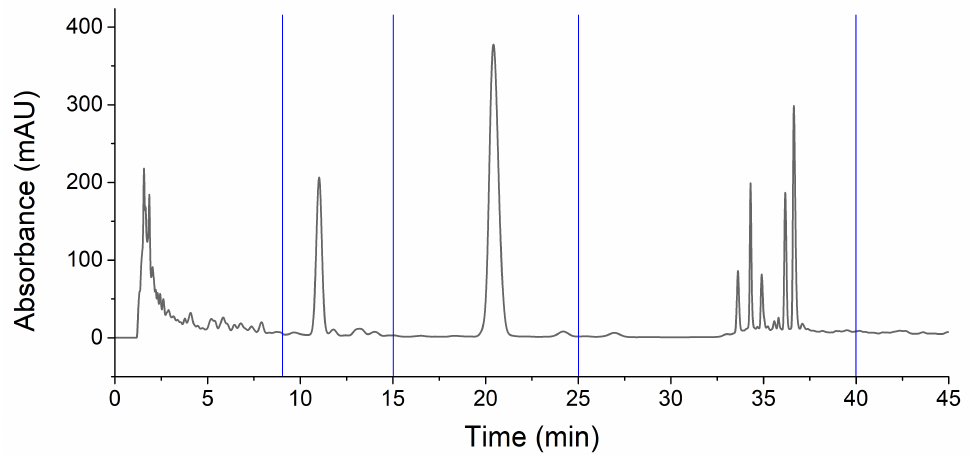
Figure 3. The chromatograms of IHLE-pe and the division of four fractions.